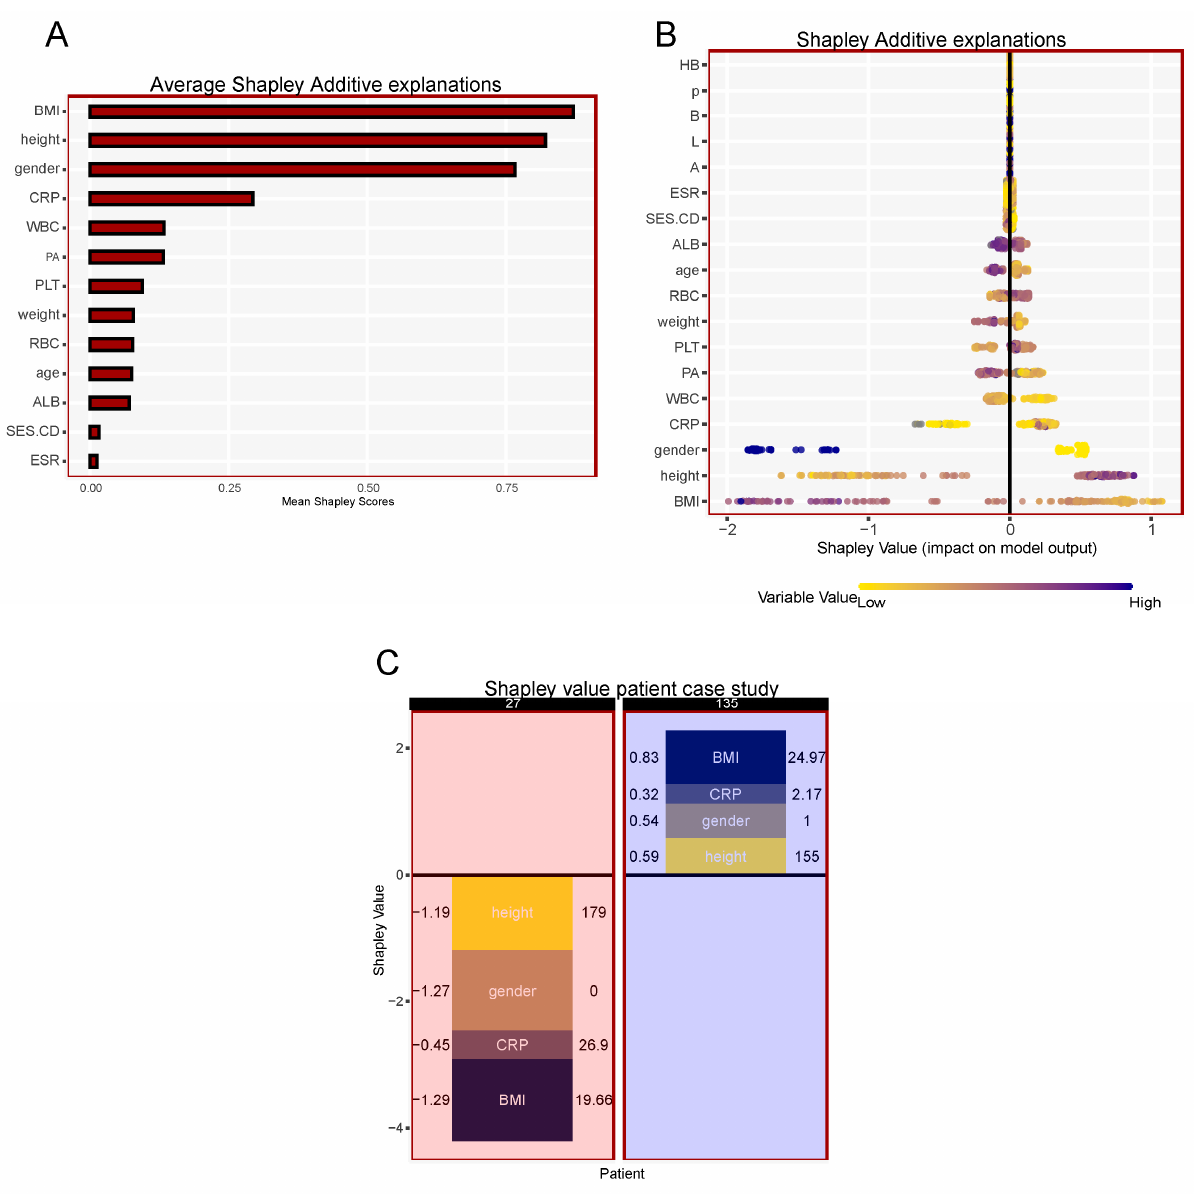
Figure 2. Ranking of the importance of the top 14 variables ( A ) with Shapley additive explanations (SHAP) summary plot ( B ) in the LightGBM model for predicting sarcopenia in Crohn’s disease. Shapley values of the top four variables based on the LightGBM model predicts sarcopenia in representative patient samples ( C ). BMI: body mass index; CRP: C-reactive protein; WBC: white blood count; PA: prealbumin; PLT: platelet; RBC: red blood count; ALB: albumin; SES-CD: simple endoscopic score for Crohn’s disease; ESR: erythrocyte sedimentation rate; HB: hemoglobin; p: perianal disease; B: disease behavior; L: disease location; A: age at diagnosis.